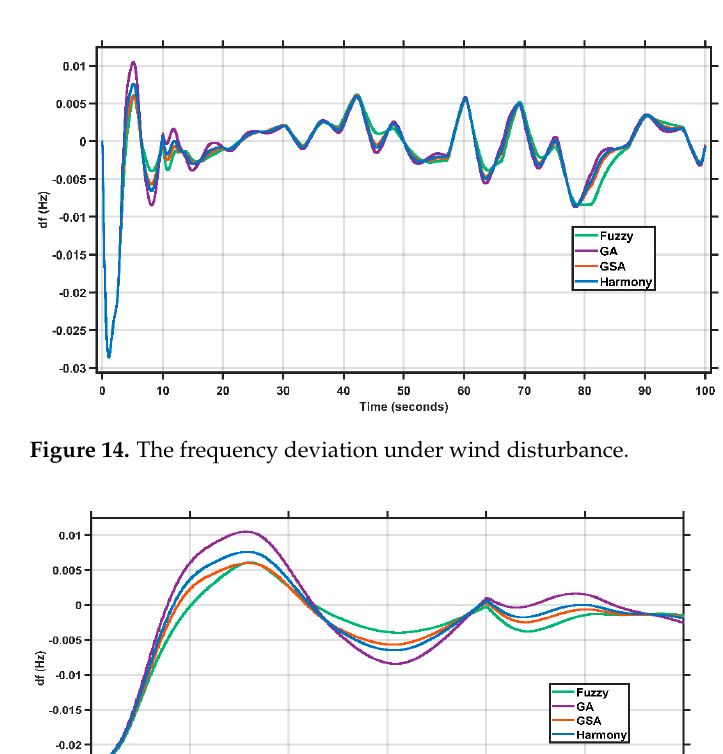
Figure 13. The output control signals of the fuzzy PI controller in case 2.